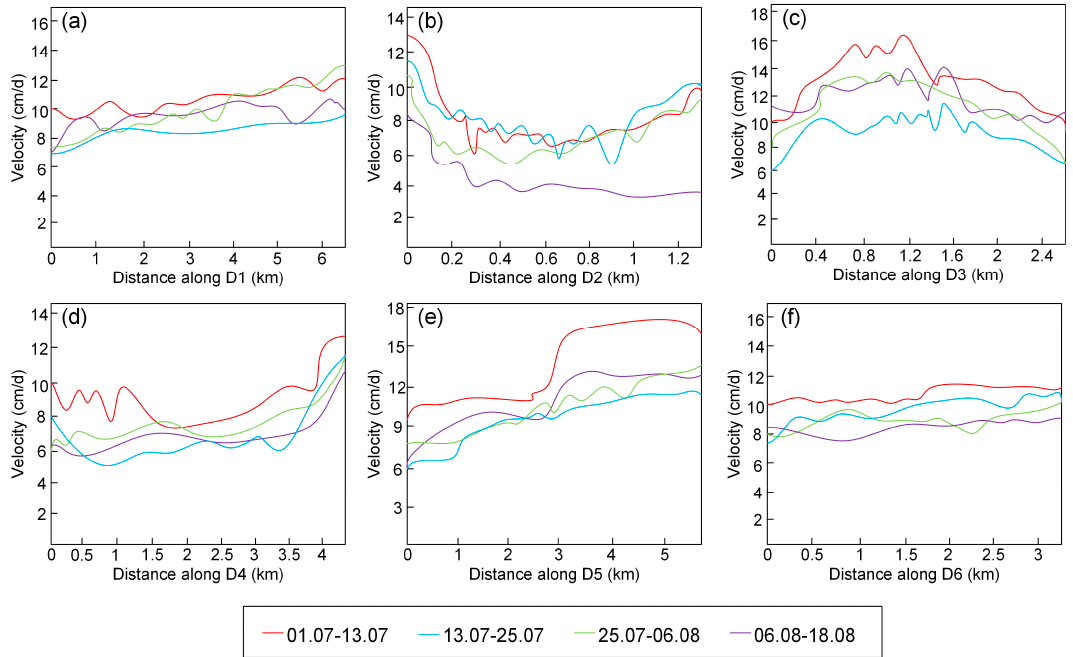
Figure 6. Velocities along the six profiles (D1 − D6) indicated in Figure 5c.